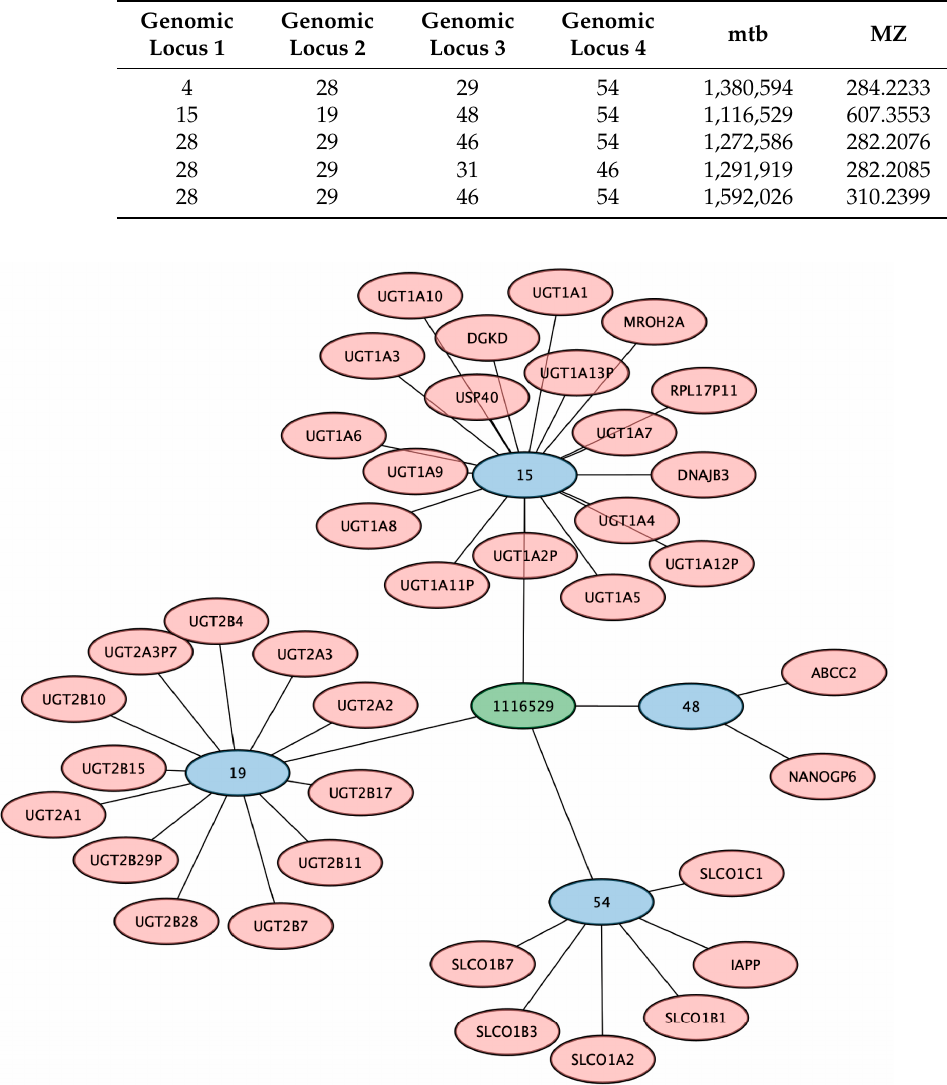
Figure 4 . Metabolite 1116529 (MZ: 607.3553, RT: 3.428667) is associated with genomic loci 15, 19, 48, and 54. SNPs within the aforementioned genomic loci are all linked to metabolite 1116529. Genomic